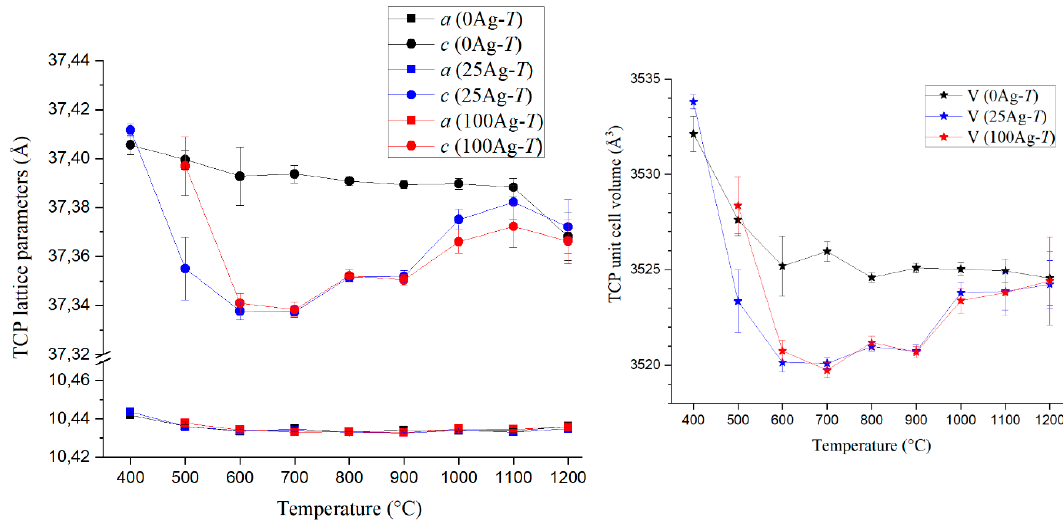
Figure 4. Thermal variation in TCP lattice parameters for the three series of samples. ( Left ): a (squares) and c (circles) trigonal lattice parameters; ( right ): unit cell volume (stars). Lines are guides for the eyes only.